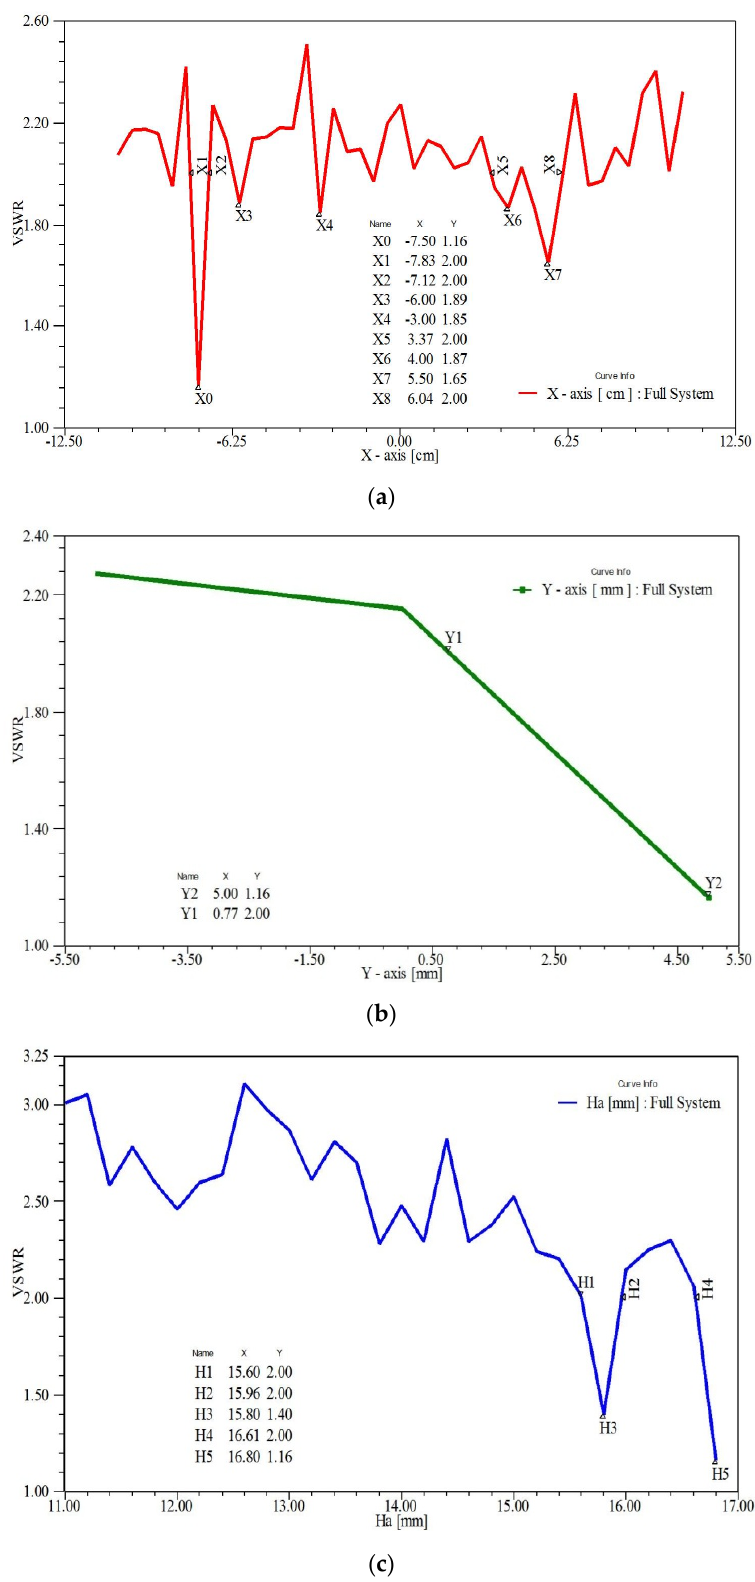
Figure 23. VSWR of proposed full satellite at 2450 MHz: Proposed antenna + 3U CubeSat: ( a ) VSWR at 2450 MHz versus Z-axis (mm): Ha (mm); ( b ): VSWR at 2450 MHz versus Y-axis (cm); ( c ): VSWR at 2450 MHz versus Z-axis (mm): Ha (mm).